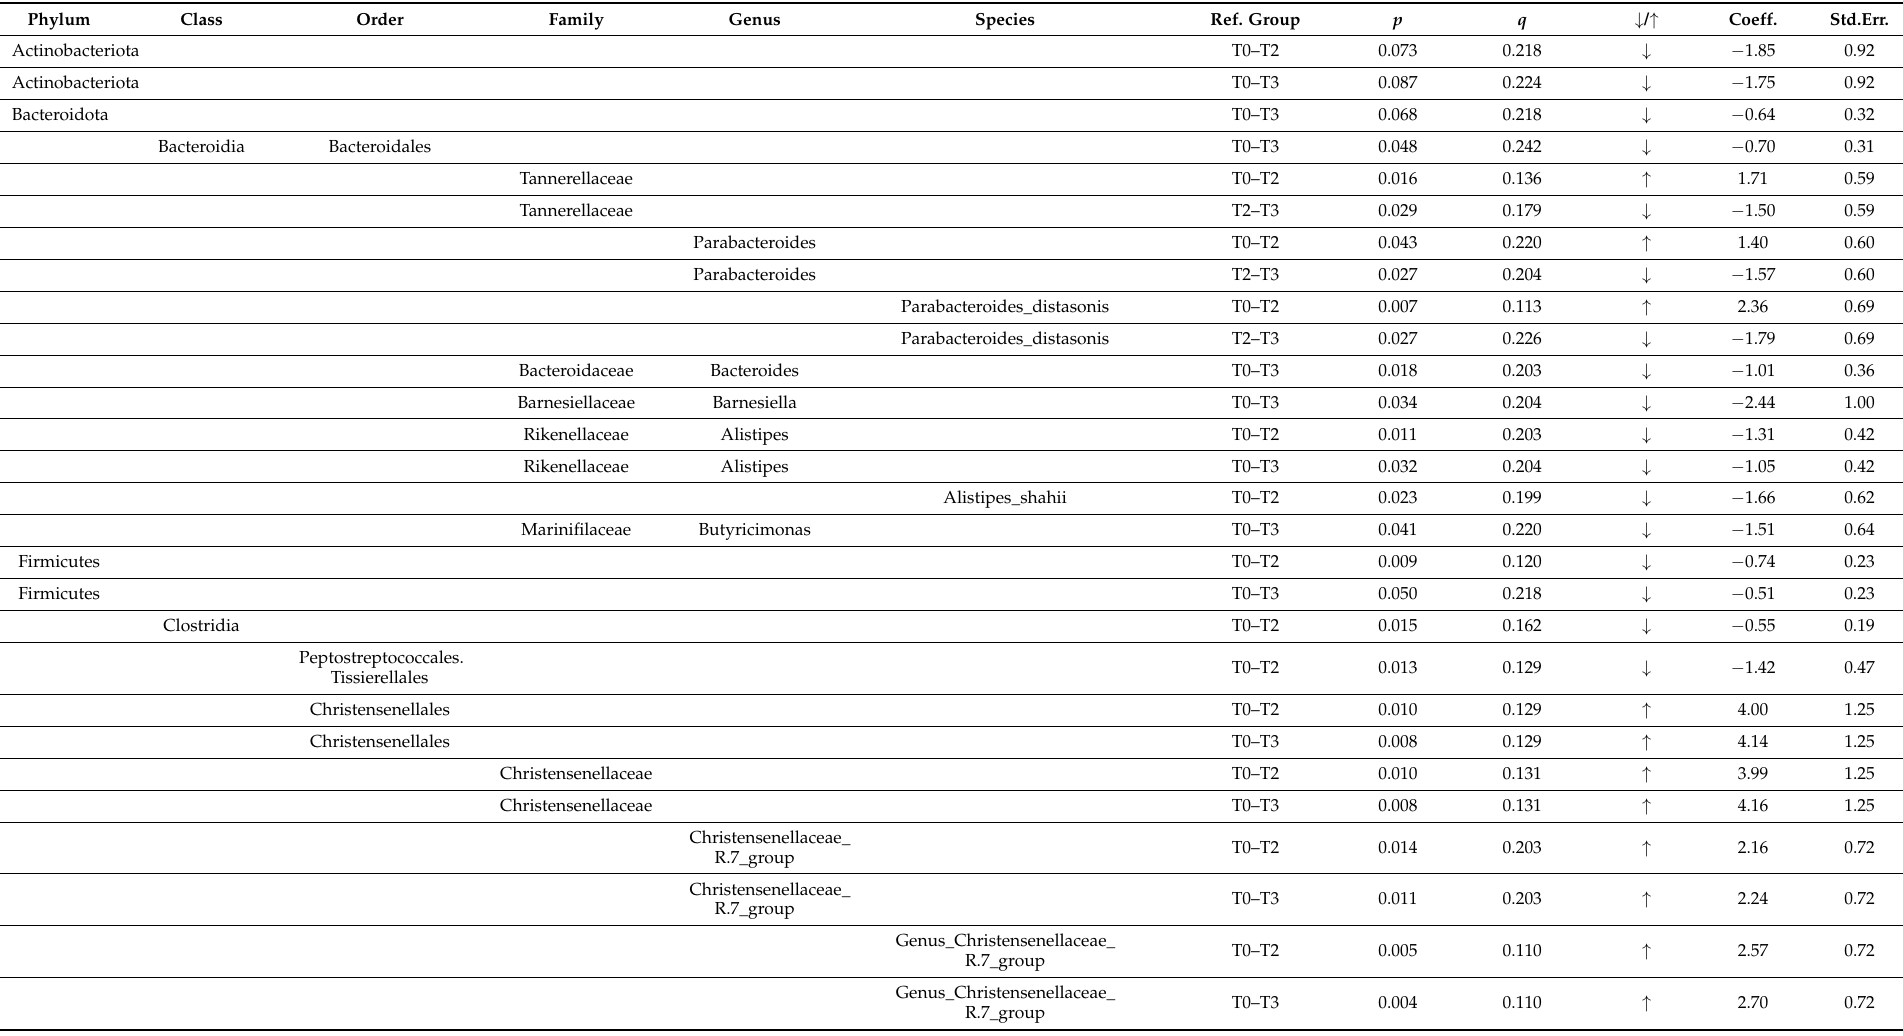
Table 4. Changes in gut microbiota taxa abundances between timepoints in the KETO